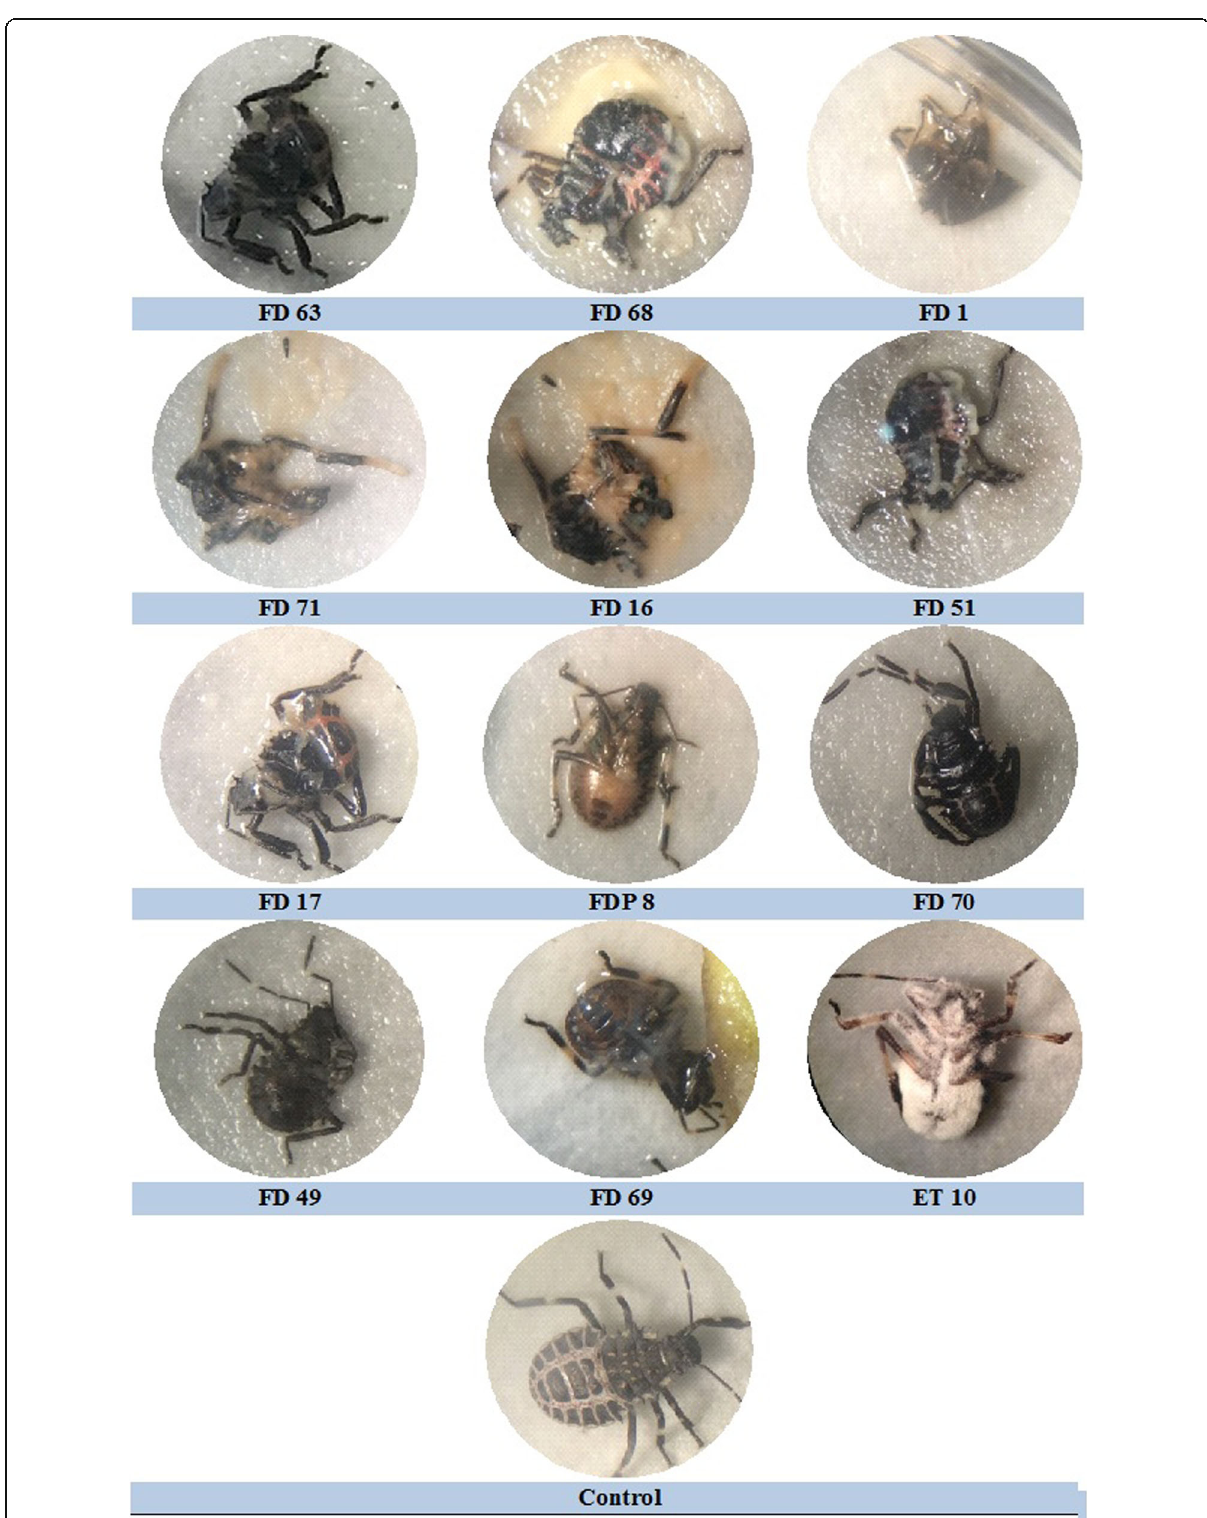
Fig. 2 Effects of the applications of bacterial strains and fungal isolate on the Halyomorpha halys nymphs after